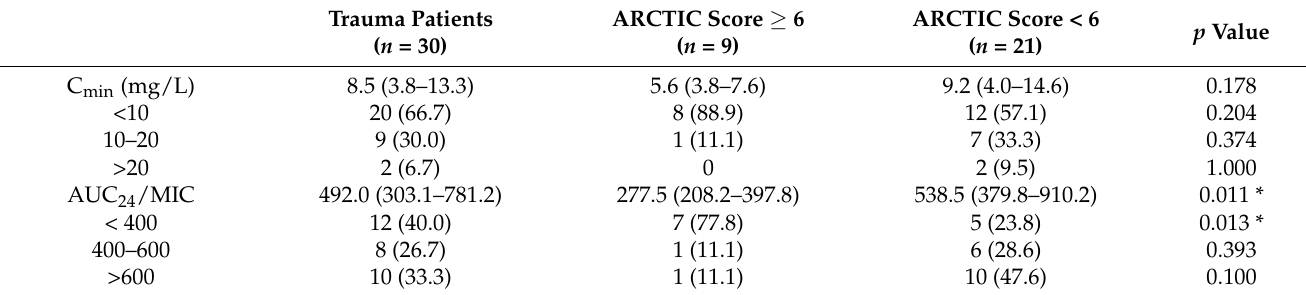
Table 6. PK/PD analysis under the evaluation of the ARCTIC scoring